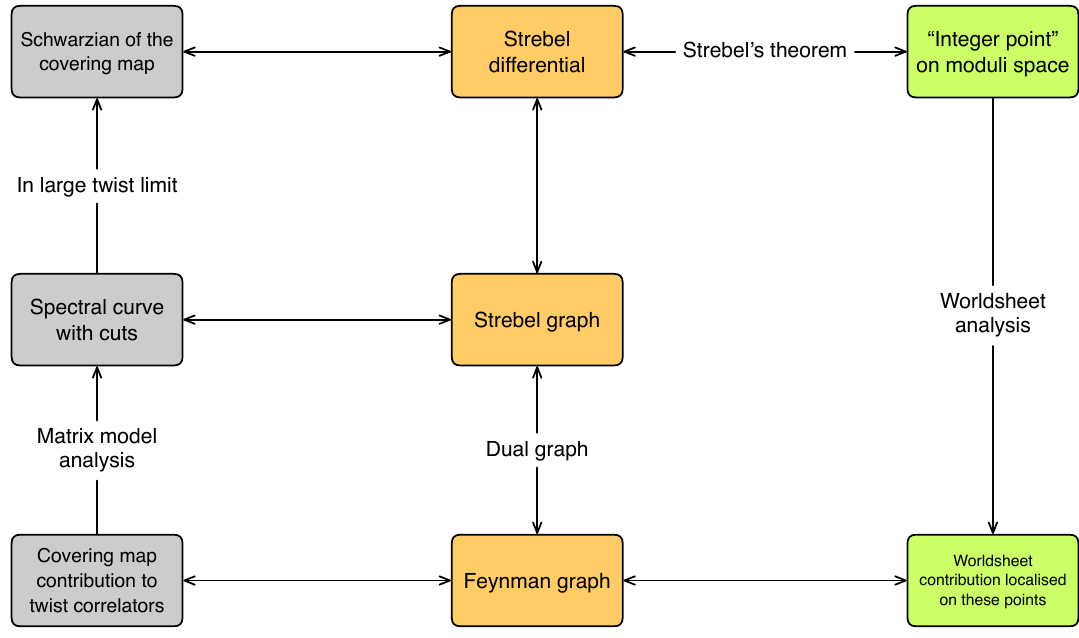
Figure 8 . Flowchart explaining the general logic of how a field theory correlator directly maps onto a worldsheet integral over string moduli space where each Feynman diagram gets associated with a point on the moduli space. This is seen in the middle and right hand verticals of the figure. The left hand side indicates the specific way the equivalence is seen in the AdS 3 case, where it proceeds via an auxiliary matrix model. This tool bridges the field theory and the string theory in this case.